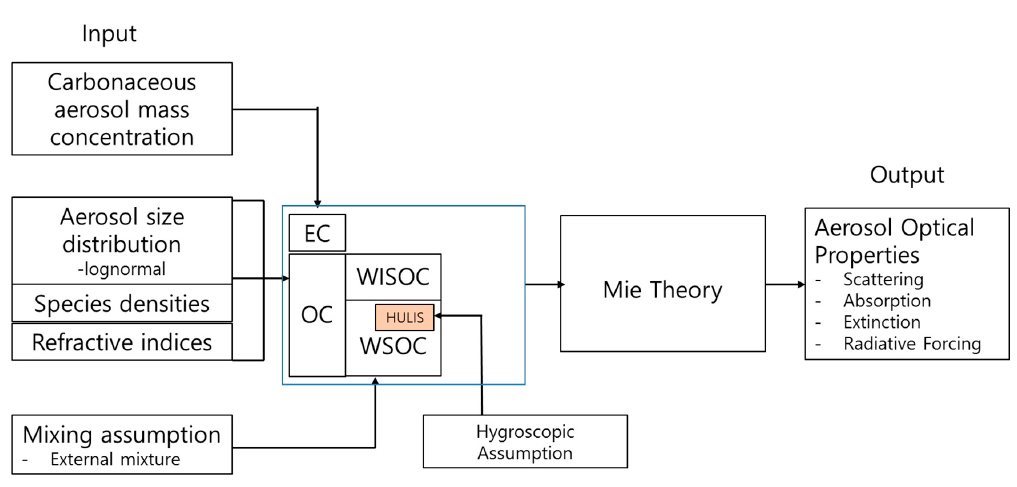
Figure 2. Schematic diagram of the aerosol optical model for carbonaceous aerosols.